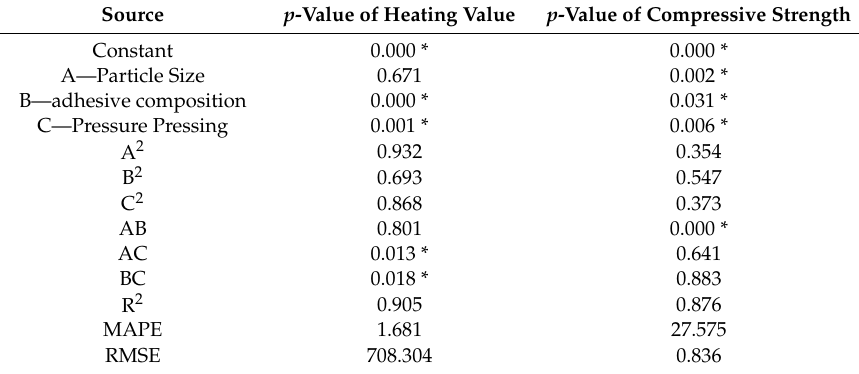
Table 5. p -value summary for the response of heating value and compressive strength.